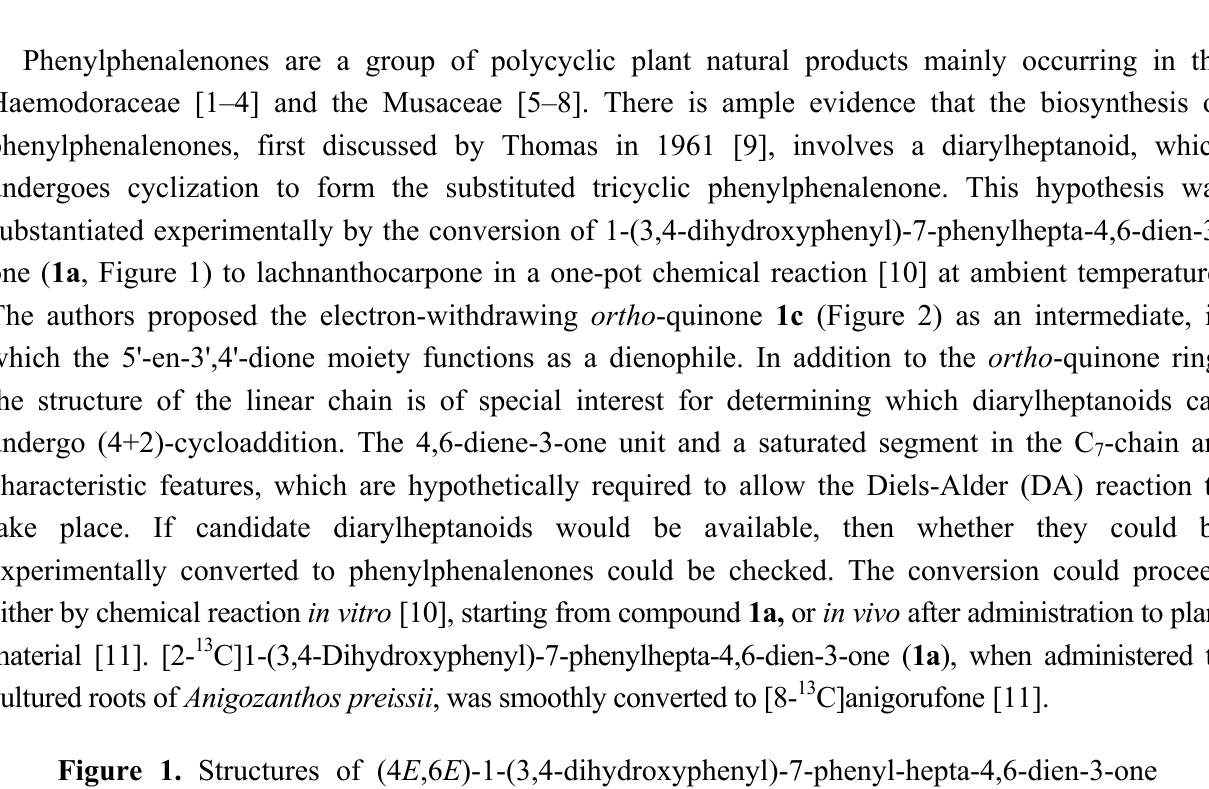
Figure 1. Structures of (4 E ,6 E )-1-(3,4-dihydroxyphenyl)-7-phenyl-hepta-4,6-dien-3-one ( 1a ) and